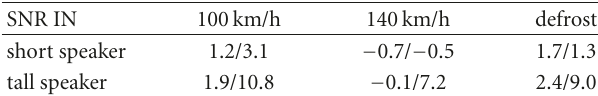
Table 1: Average input SNR values [dB] from mic. 1/mic. 2 for typical background noise conditions in a car.